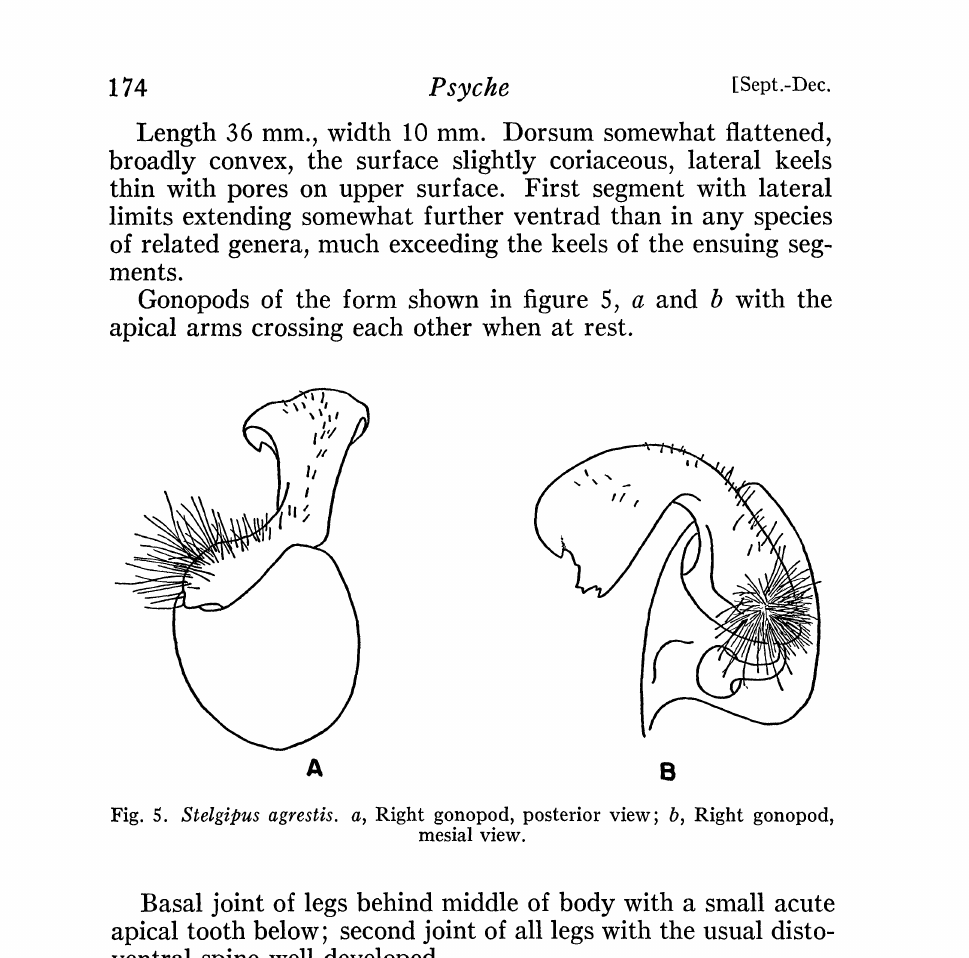
Fig. 5. Stelgipus agrestis, a, Right gonopod, posterior view; b, Right gonopod, mesial view. Basal joint of legs behind middle of body with a small acute apical tooth below; second joint of all legs with the usual disto- ventral spine well